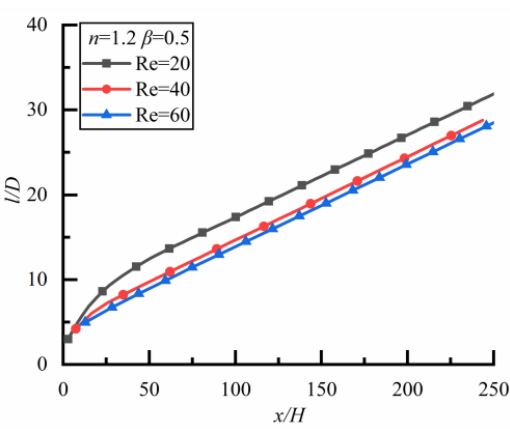
Figure 11. Changes of l/D along flow direction for different Re ( n =1.2). ( a ) β =0.5, ( b ) β =2.